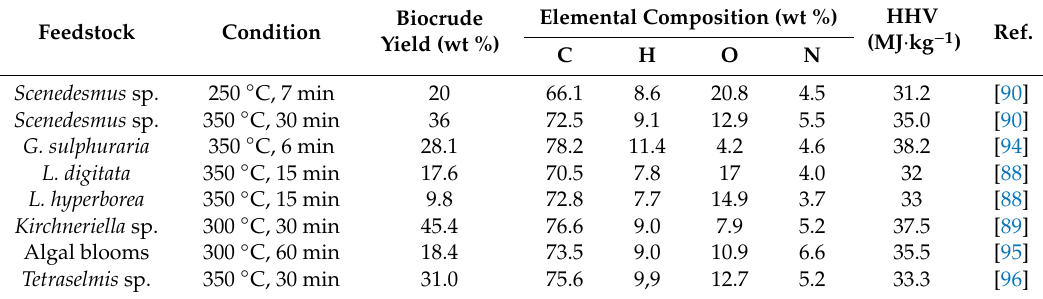
Table 2. Properties of biocrude from non-catalytic